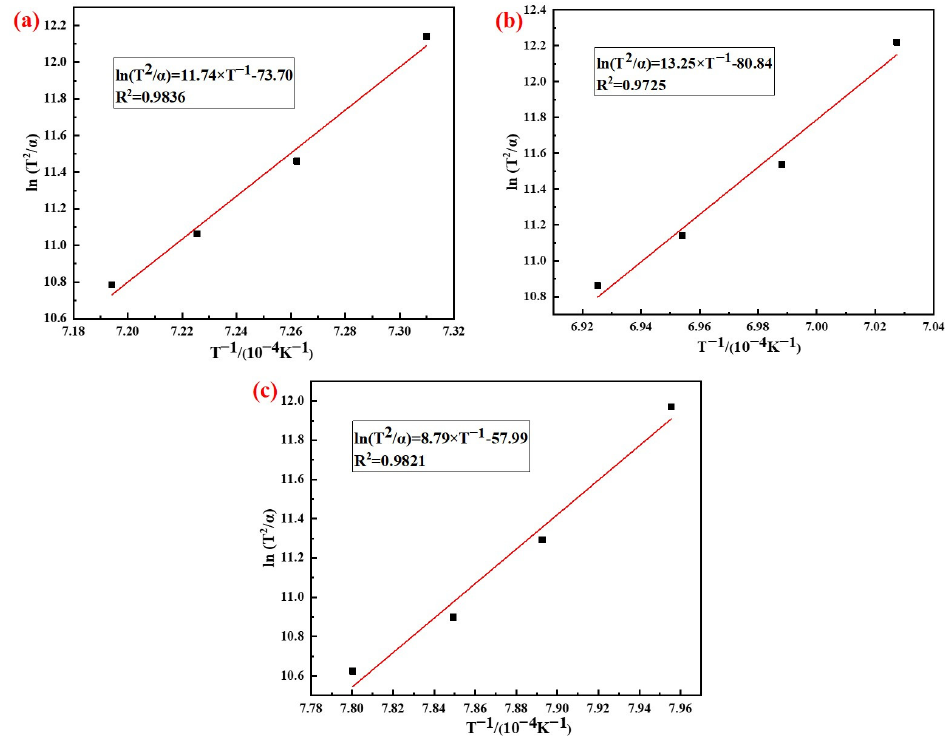
Figure 8. Analysis results of the Kissinger method: ( a ) Fly ash; ( b ) Silica dust; ( c ) Gangue.